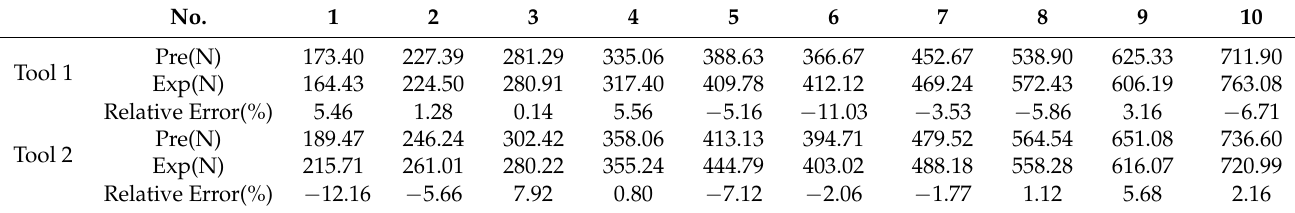
Table 7. Comparisons between experimental and predicted resultant forces F w